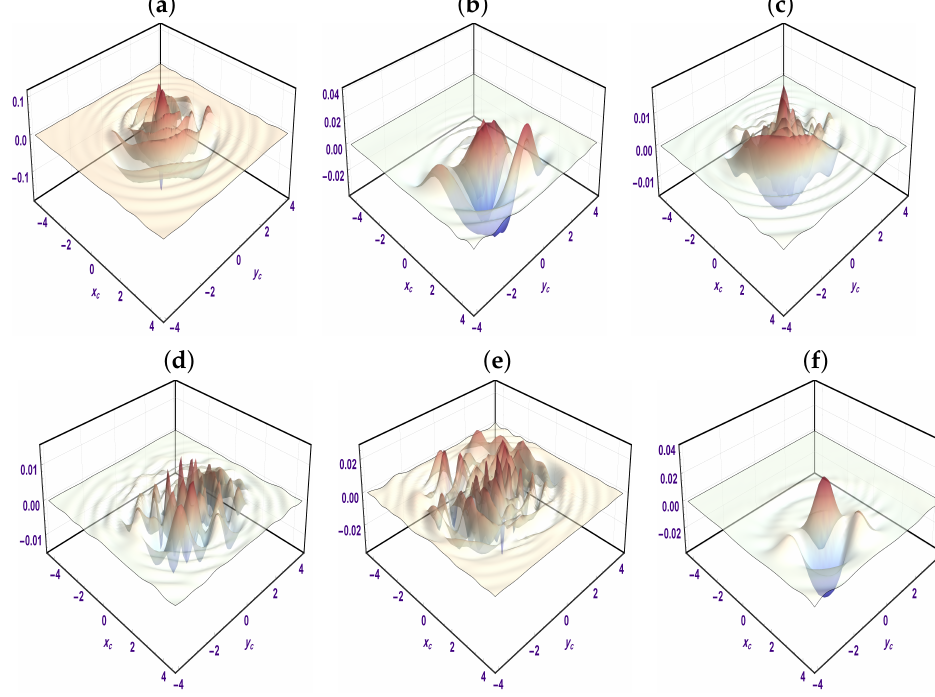
Figure 3. The behaviour of W as a function of x c , y c , where Γ 2 = 0.5 ( 1 + I ) , where ( a ) θ = 0, λ 1 = 1 = λ 2 = λ 3 ; ( b ) θ = π /4, λ 1 = 1 = λ 2 = λ 3 ; ( c ) θ = π /2, λ 1 = 1 = λ 2 = λ 3 ; ( d ) θ = π /4, λ 3 = 2, λ 1 = 1 = λ 2 ; ( e ) θ = π /4, λ 2 = 2, λ 1 = 1 = λ 3 ; ( f ) θ = π /4, λ 1 = 2, λ 2 = 1 = λ 3